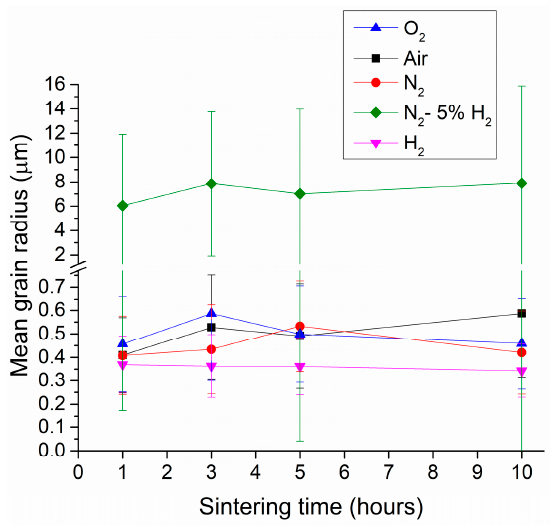
Figure 5. Mean grain radius of KNbO 3 samples sintered at 1040 °C for 1–10 h in different atmospheres. Grain size distributions of KNbO 3 samples sintered at 1040